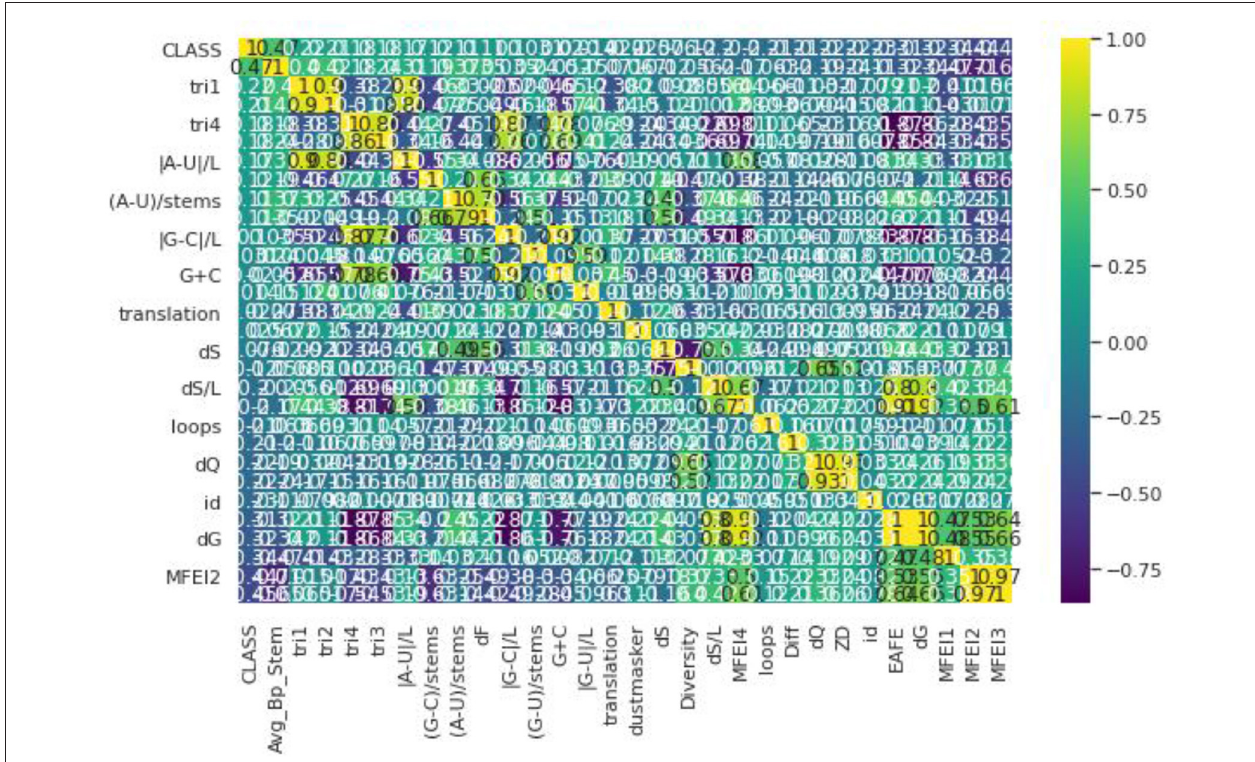
FIGURE 1 | Correlation